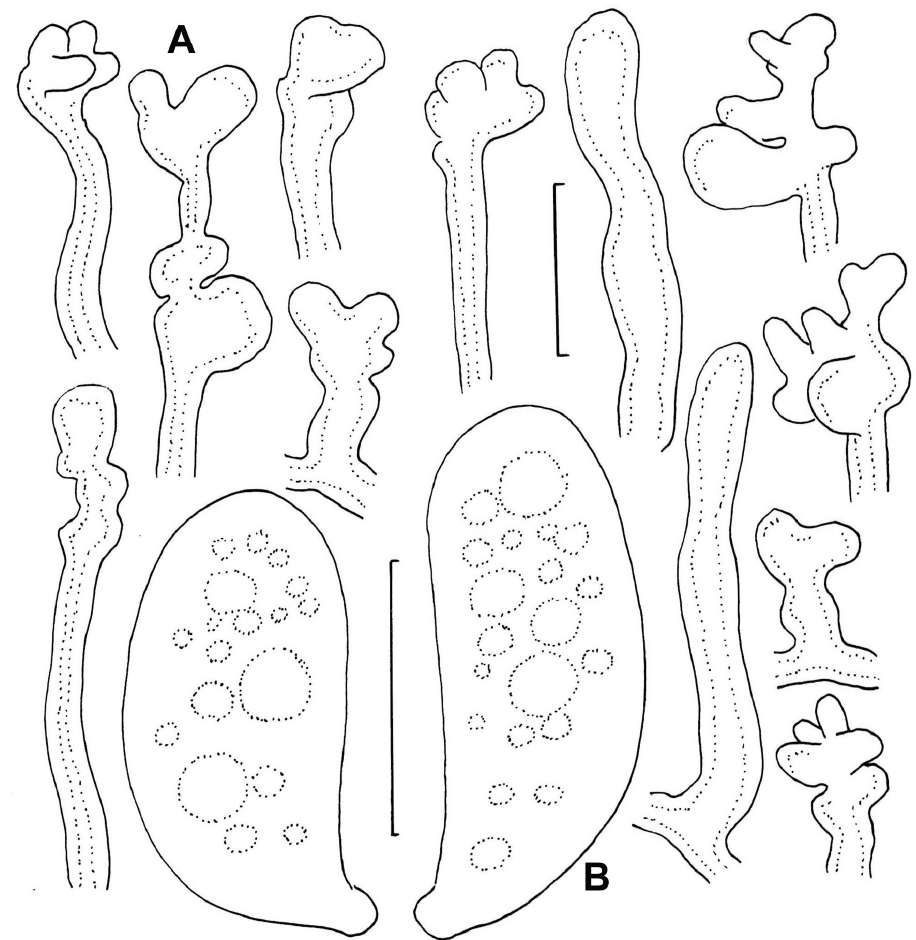
Figure 58. Mycetinis opacus . A Caulocystidia B Basidiospores. Standard bar: A = 20 µm; B = 5 µm. TFB 14629